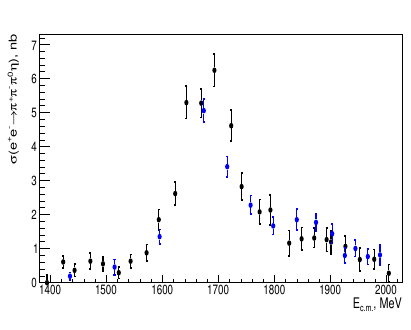
Figure 2. The e + e − → ηπ + π − π 0 cross section. Black and blue colors are for the 2011 and 2012 data, respectively.